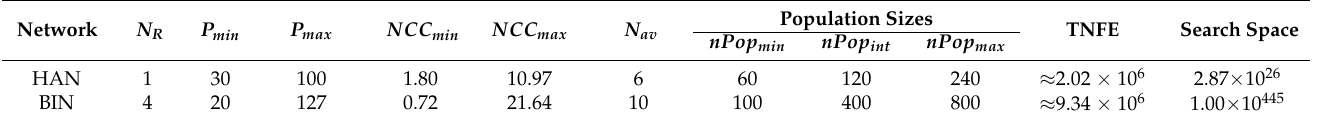
Table 1. Data of WDS benchmark problems used in this